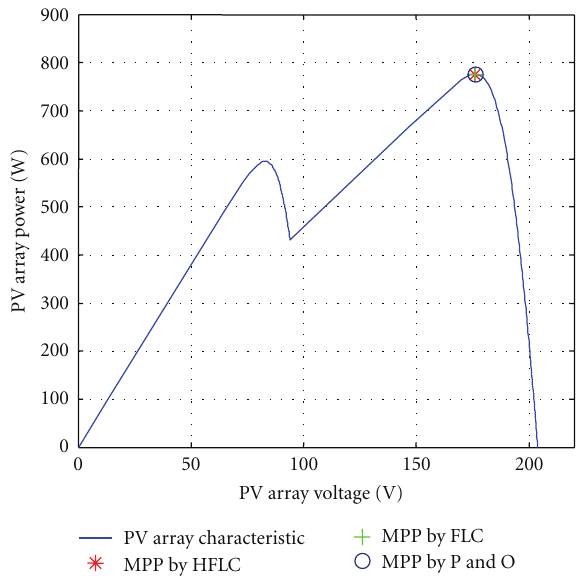
Figure 26: MPP under partial shading 200W/m 2 and 1000 W/m 2 .